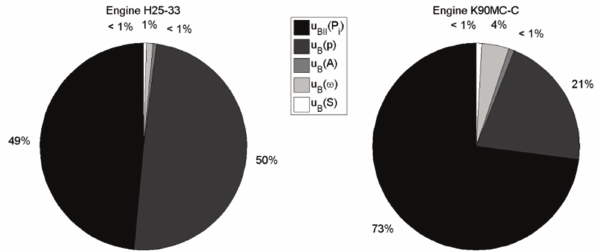
u $ (cid:22)p(cid:24) – cylinder gas pressure uncertainty, – piston surface uncertainty, u $ (cid:22)A(cid:24) – piston position uncertainty u $ (cid:22)S(cid:24)